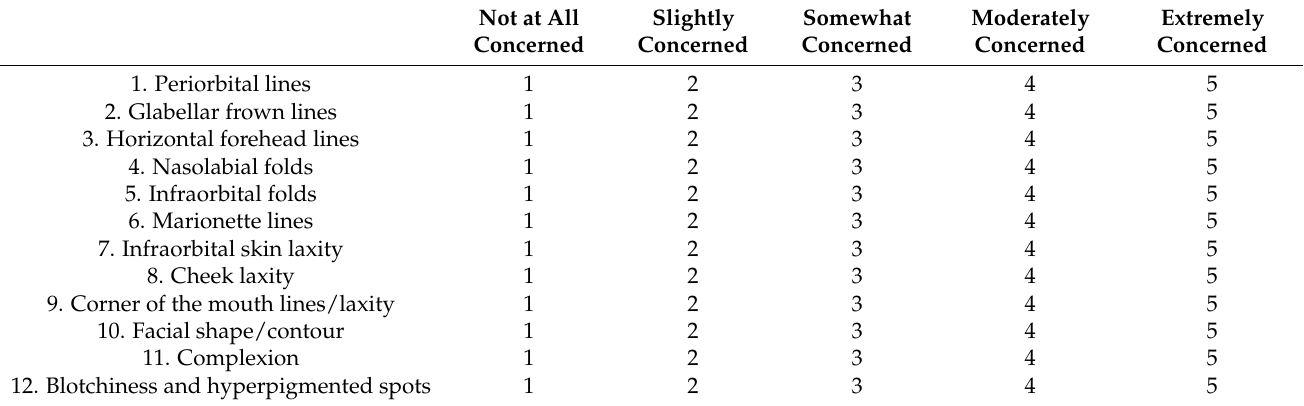
Table 1. The 12 items on the facial check